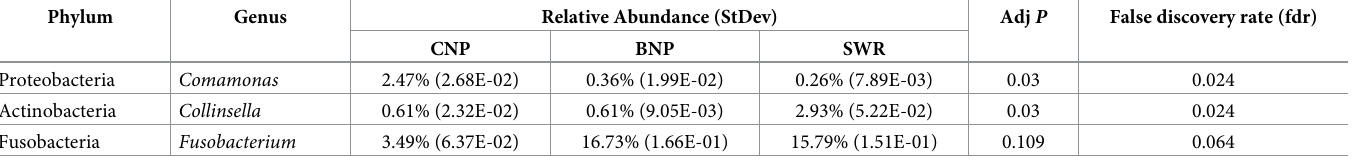
Table 3. Statistical analysis for most prevalent microbial phyla and genera in gut microbiota found in three sub-populations of tigers in Nepal.